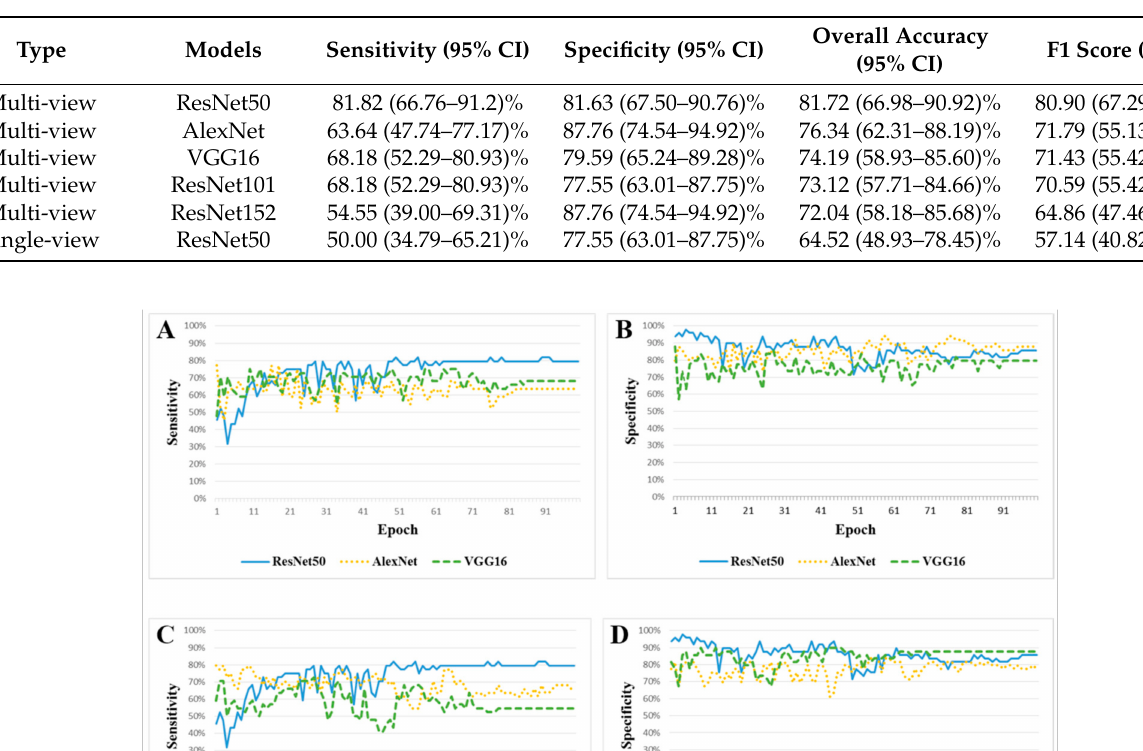
Table 3. Binary classification of rupture risk involving small UIAs in the test dataset using various CNN architectures. CI, confidence interval.